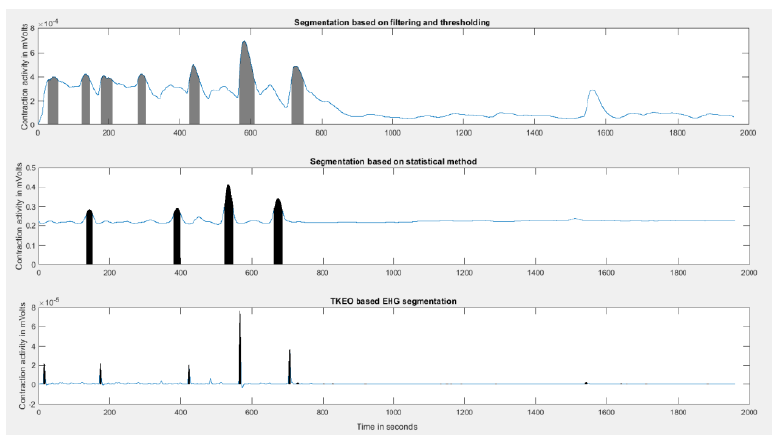
Fig. 2: A comparison of contractions detected using the three methods for the same signal. Top represents the filtering method. Middle represents the statistical method. Bottom represents the TKEO method.